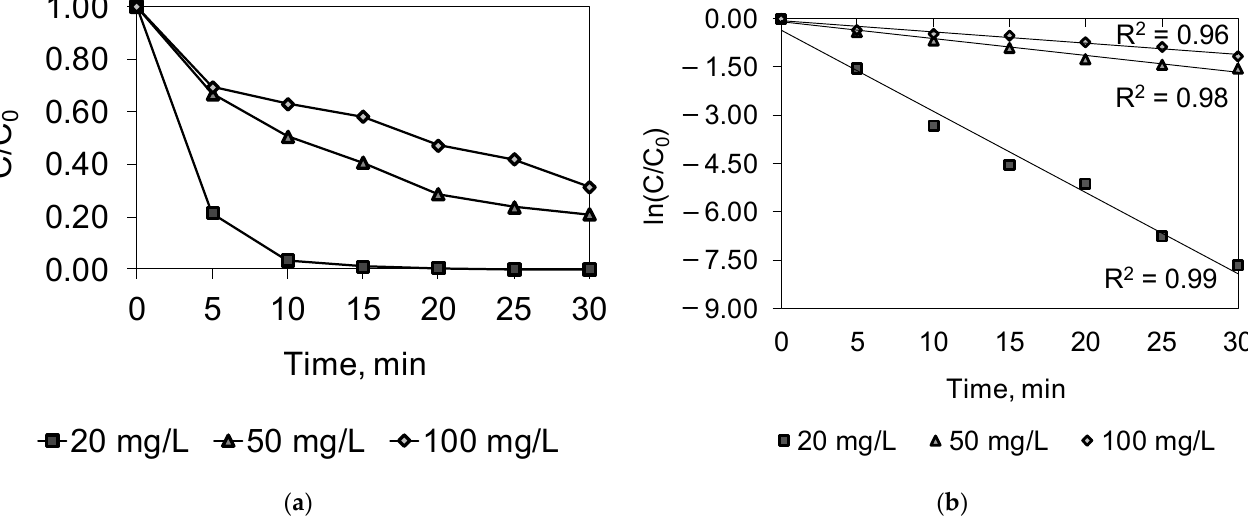
Figure 3. Photodegradation of rhodamine B during different AOP ( a ) and reaction kinetics ( b ). Conditions: C 0[RhB] = 20–100 mg/L; V = 0.5 L; T = 298.0 K; p = 1013.0 hPa; pH = 6.0; t = 0–30 min.